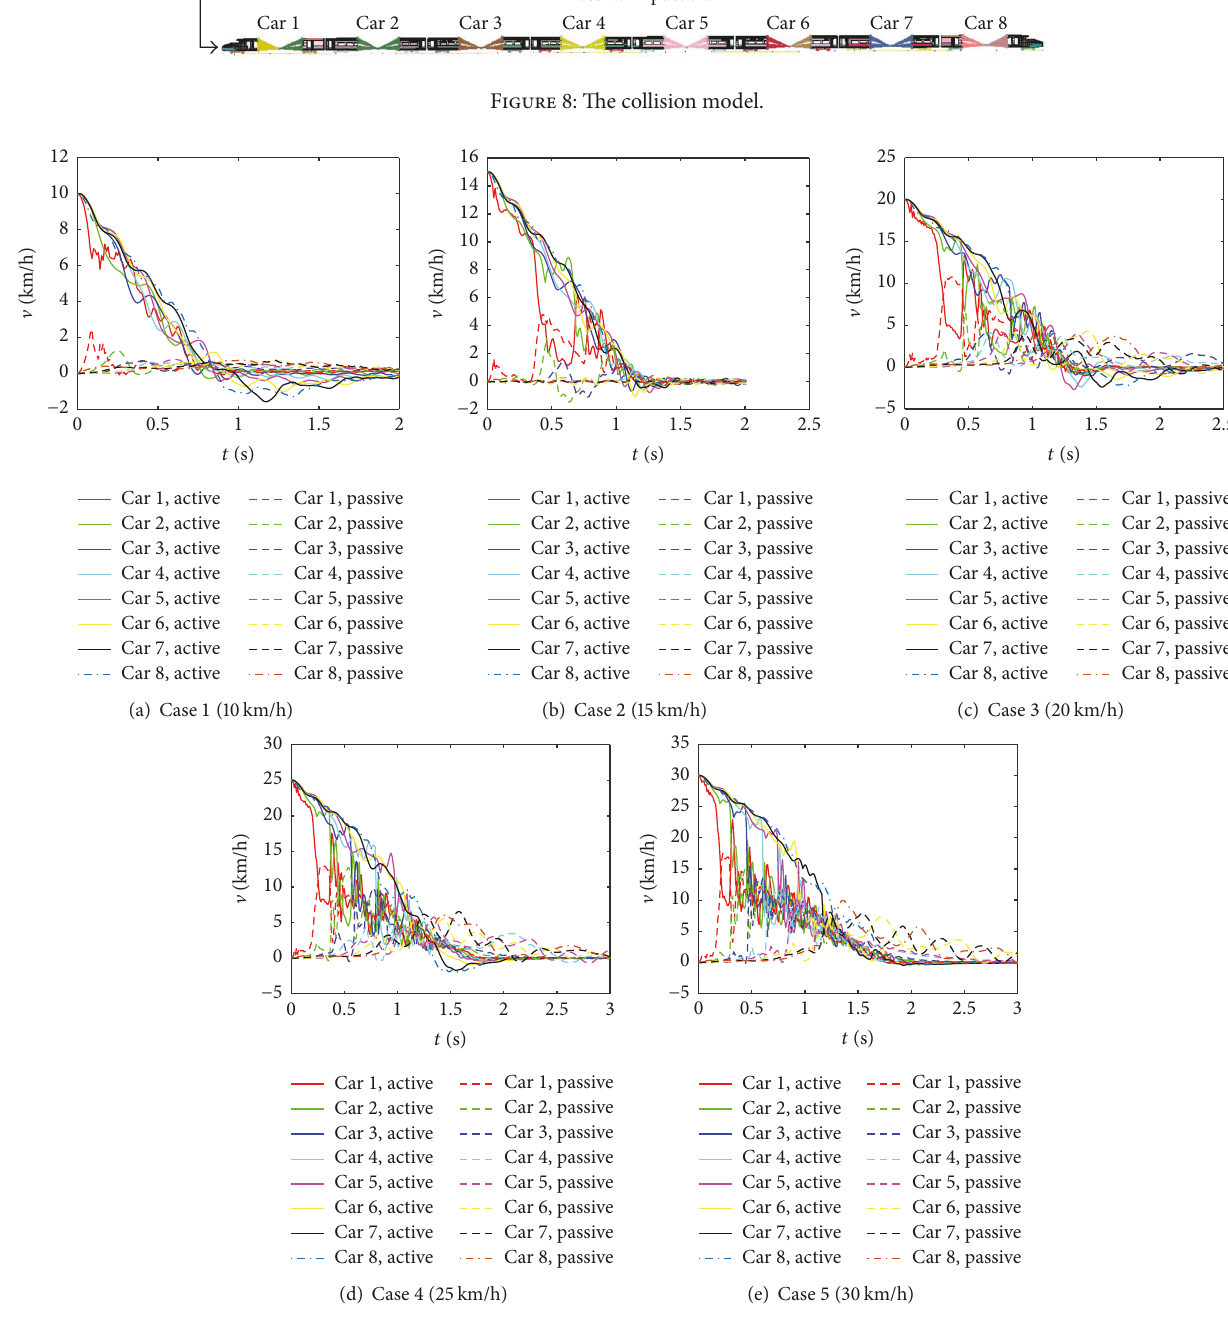
Figure 9: Velocity-time curves for all